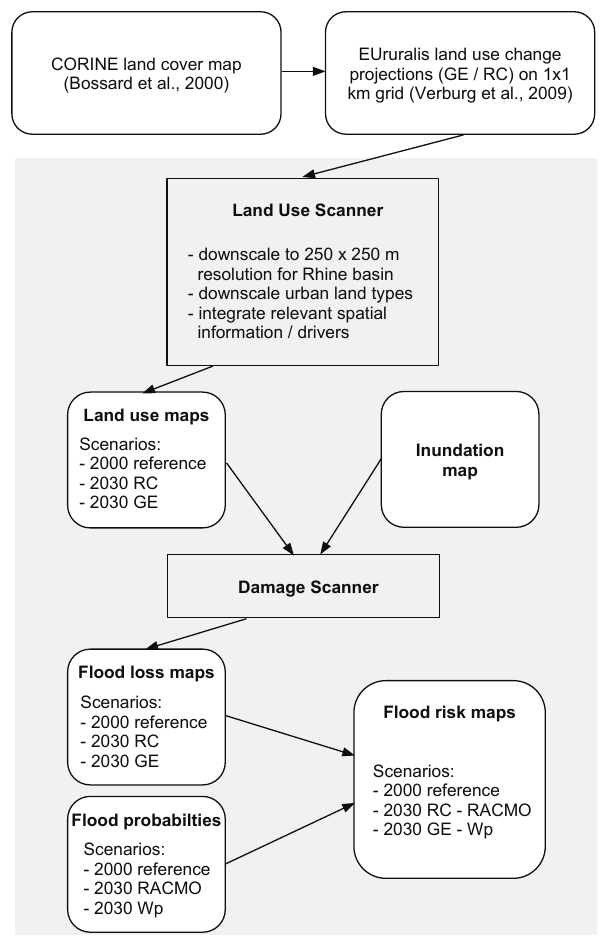
Fig. 2. Flowchart of the method used for estimating future flood